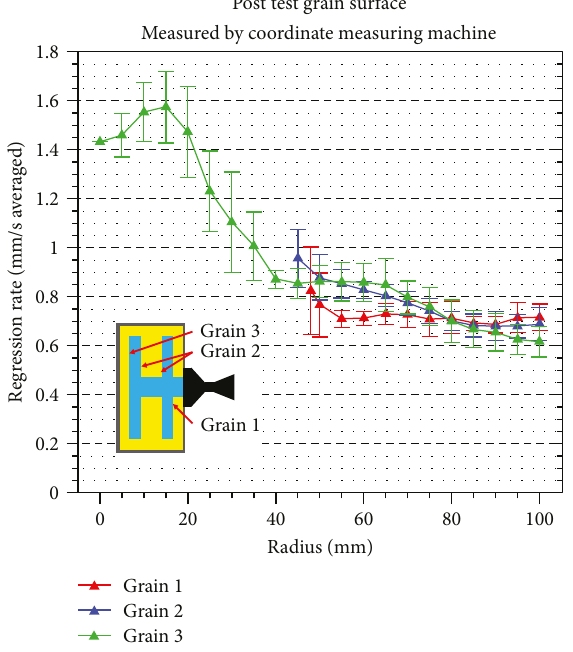
Figure 16: Measured grain regressed thickness for di ff erent grain fuel surfaces of the DVF engine after hot- fi re test. Table 3: Comparison of numerical and test data of 250kgf class DVF